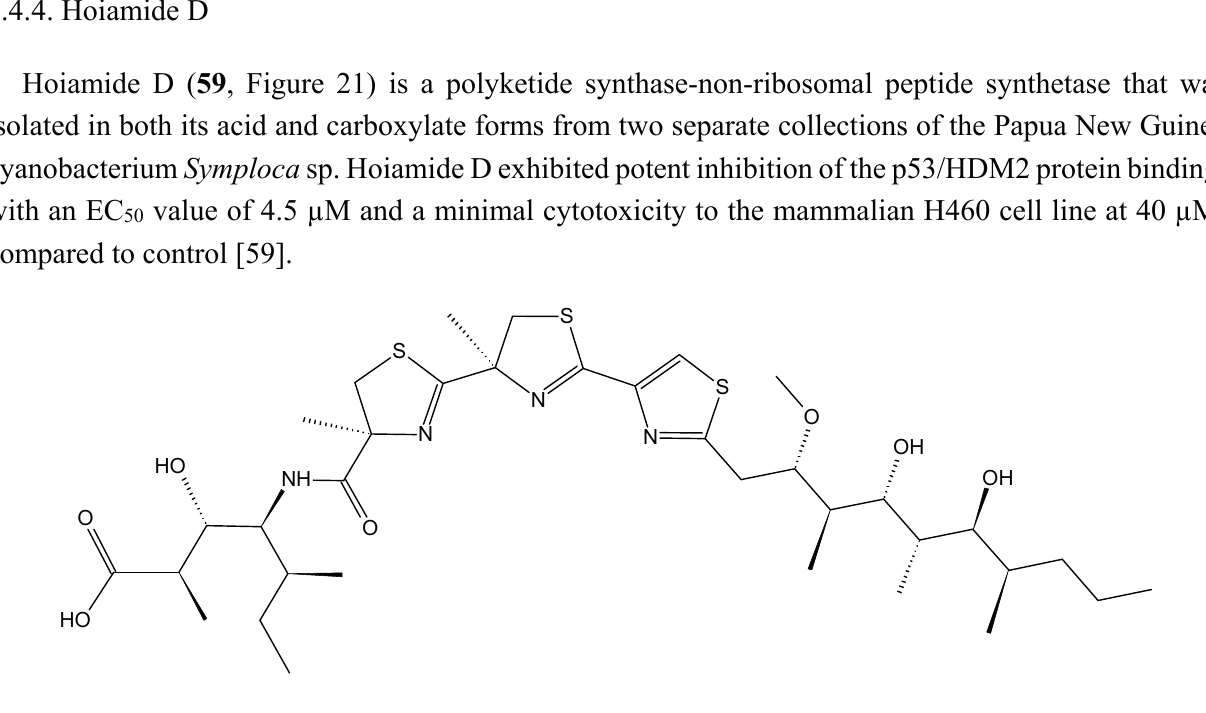
Figure 20. Cordyheptapeptide C, D and E.